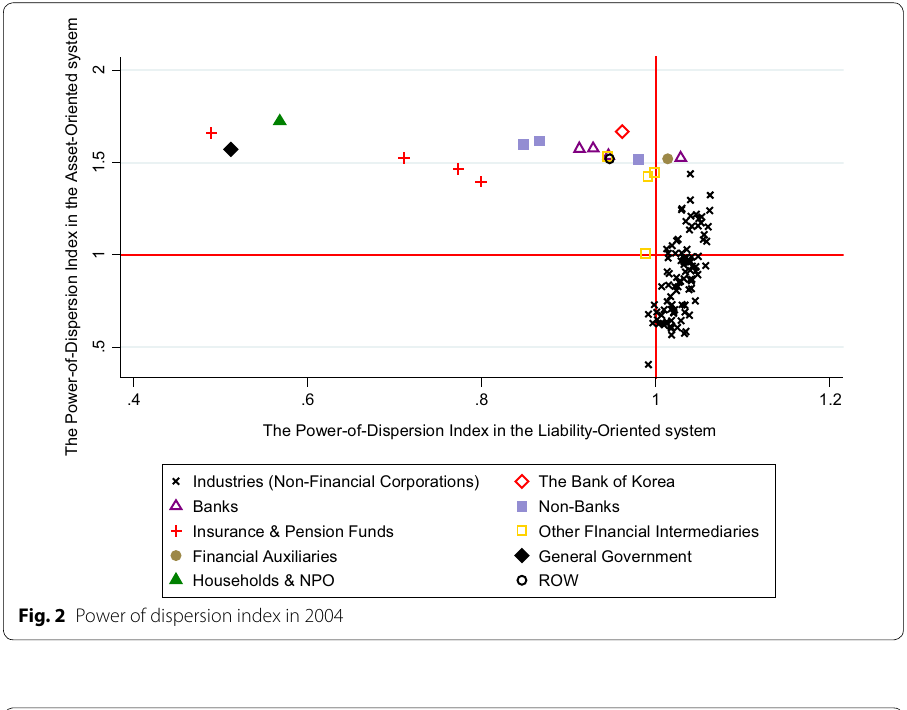
Fig. 2 Power of dispersion index in 2004